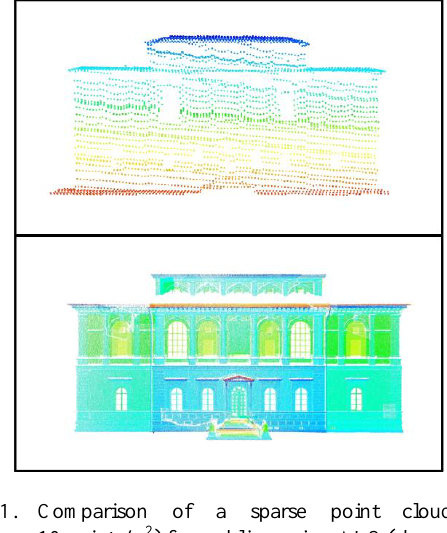
Figure 1. Comparison of a sparse point cloud (~5- 10 points/m 2 ) from oblique view ALS (above) with a dense point cloud (~200points/m 2 ) from terrestrial laser scanning